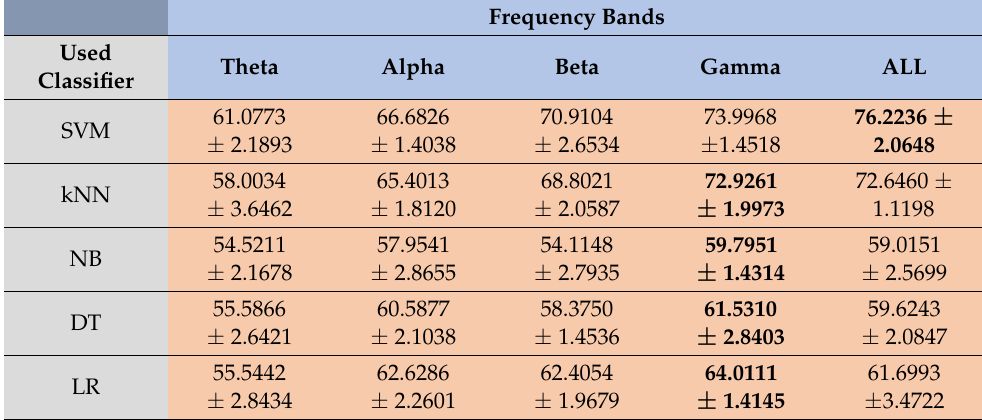
Table 1. The achievements of the DE features with SVM, kNN, NB, DT, and LR classifier. The bold cases show the highest average accuracy